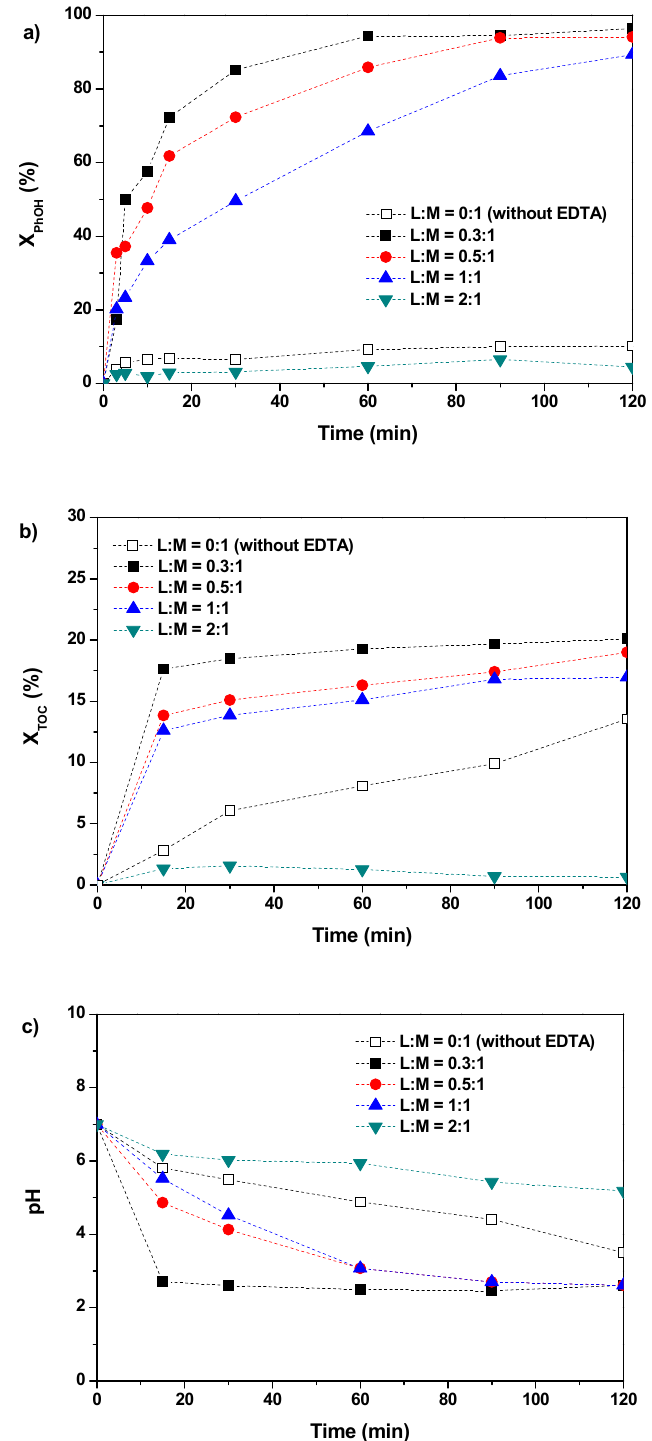
Figure 4. Phenol conversion ( a ), TOC conversion ( b ), and pH evolution ( c ) versus time for different EDTA:Fe molar ratio. [Phenol] = 1000 mg/L, [H 2 O 2 ] = 5000 mg/L, [Fe 2+ ] 0 = 7 mg/L, T = 30 °C, [pH] 0 = 7.0, and t = 120 min .